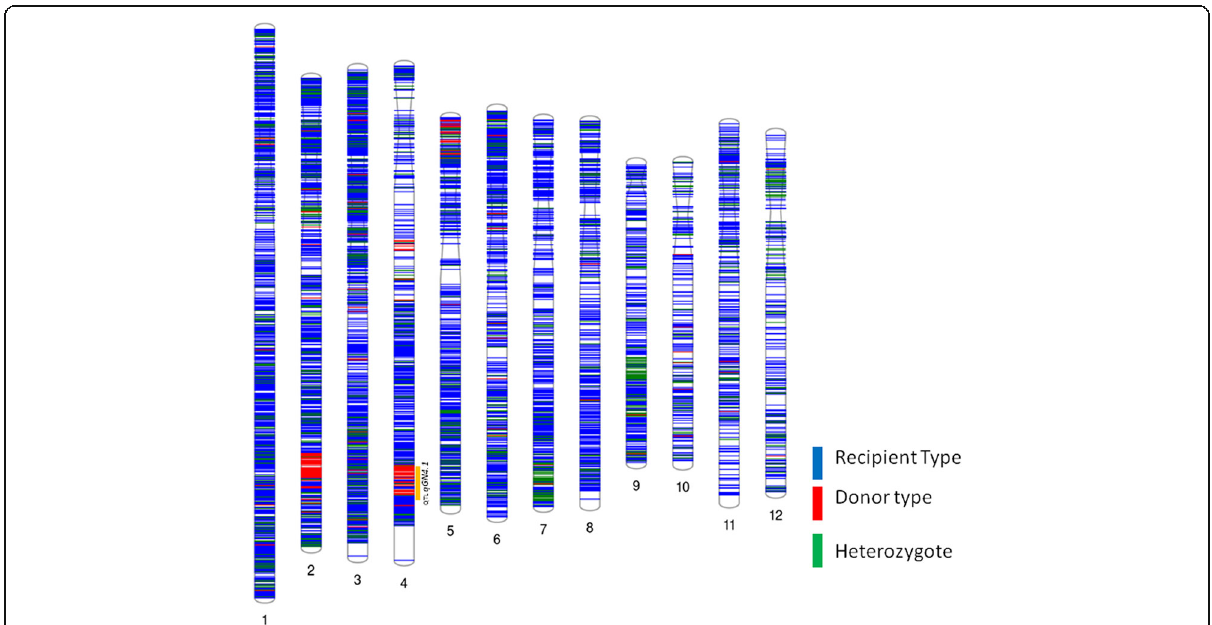
Fig. 5 Graphical representation of RPG similarity of high grain number QTL-NIL PB 1121- qGN4.1 with the PB 1121 using 50 K